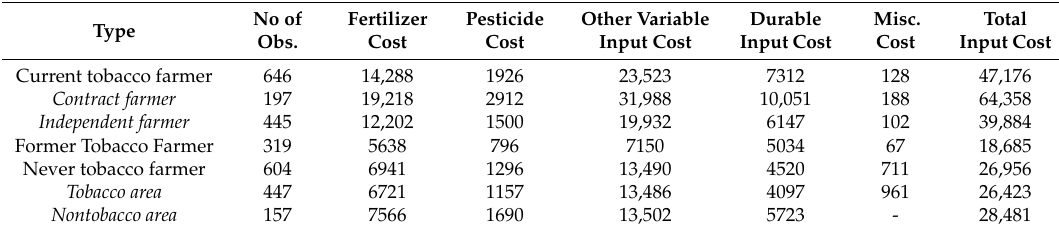
Table 7. Average cost of inputs per household in per crop terms for tobacco / alternative crop production by farmer type.